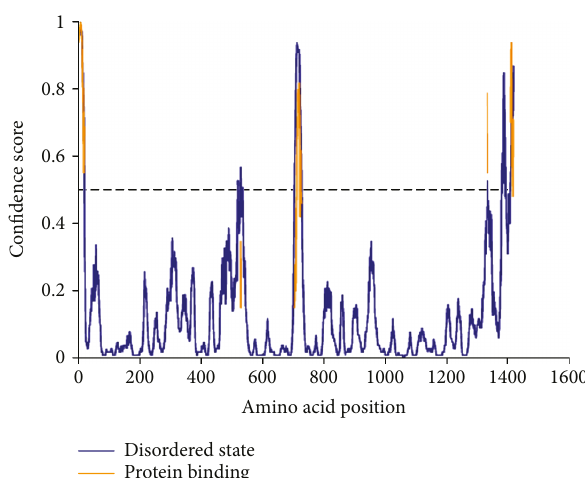
Figure 6: Disordered regions of the OROV polyprotein. Here, amino acids in the input sequence are considered disordered when the blue line is above the grey dashed line, that is, the con fi dence score is higher than 0.5. The orange line shows the con fi dence of disordered protein-binding residue predictions.